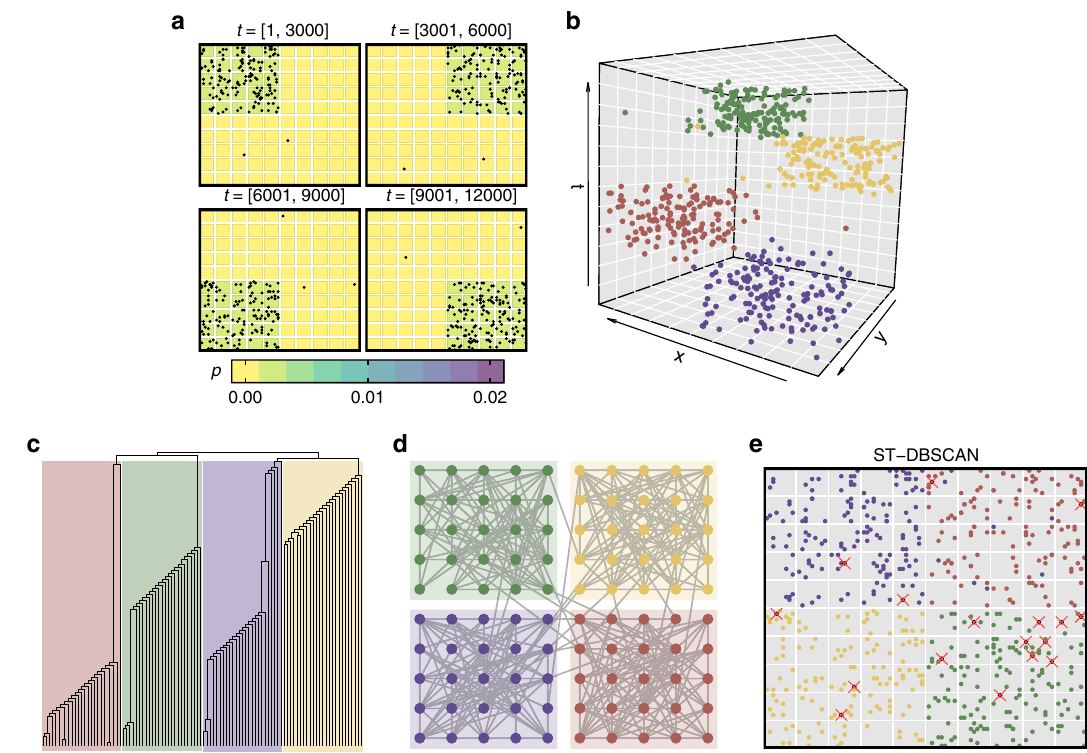
Fig. 4 Community structure in chronnets. a We propose an arti fi cial data set constructed by changing the event probability distribution P in four intervals with total time T = 12,000. Each of the four small grids illustrates the probabilities and the generated events in those intervals. A few outlier events were generated, represented by points outside the region with higher probability. b The resulting data set is composed by merging the events generated during the four periods, represented by colors. c Dendrogram obtained by the Fast greedy algorithm 24 . Different colors represent the four communities achieved with the best modularity division. d The resulting chronnet is presented in a grid layout that corresponds to the same position in the data set grid. e Spatiotemporal clustering using ST-DBSCAN 25 where “ × ” denotes events that were incorrectly